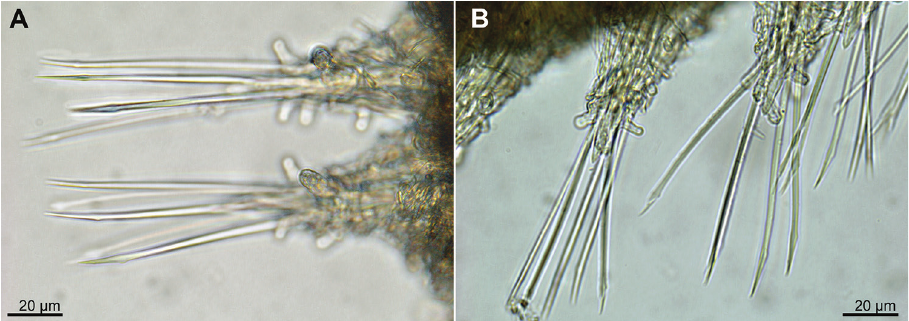
Figure 1. Ephesiopsis guayanae paratypes LACM-AHF POLY TYPE 943, micrographs. A Mid-body chaetigers and chaetae (apparently simple), ventral view B Mid-body chaetigers with compound and simple chaetae, dorsal